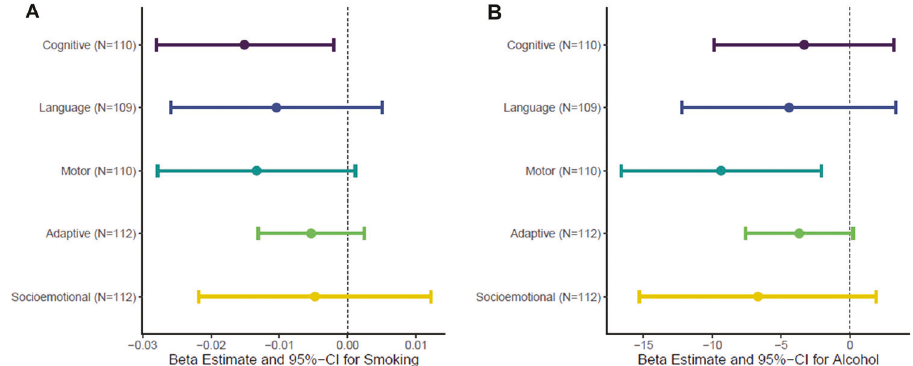
Fig. 1 Association of PTE and PAE on neurodevelopment domains at 6 months. Models were adjusted for parental SES, maternal depression, maternal psychological distress, gestational age, maternal age, maternal HIV status, cell-type proportions, and the fi rst fi ve genetic principal components. A Association of PTE on neurodevelopment domains, additionally adjusted for PAE. B Association of PAE on neurodevelopment domains, additionally adjusted for